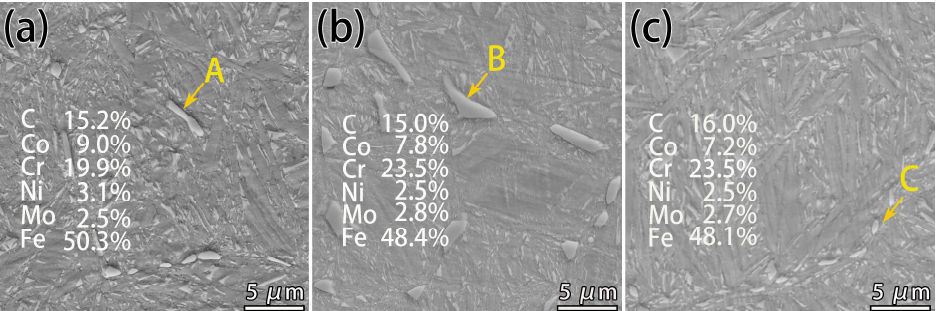
Figure 5. SEM of surface layer 0.1 mm: ( a ) process L1; ( b ) process L2; ( c ) process L3.